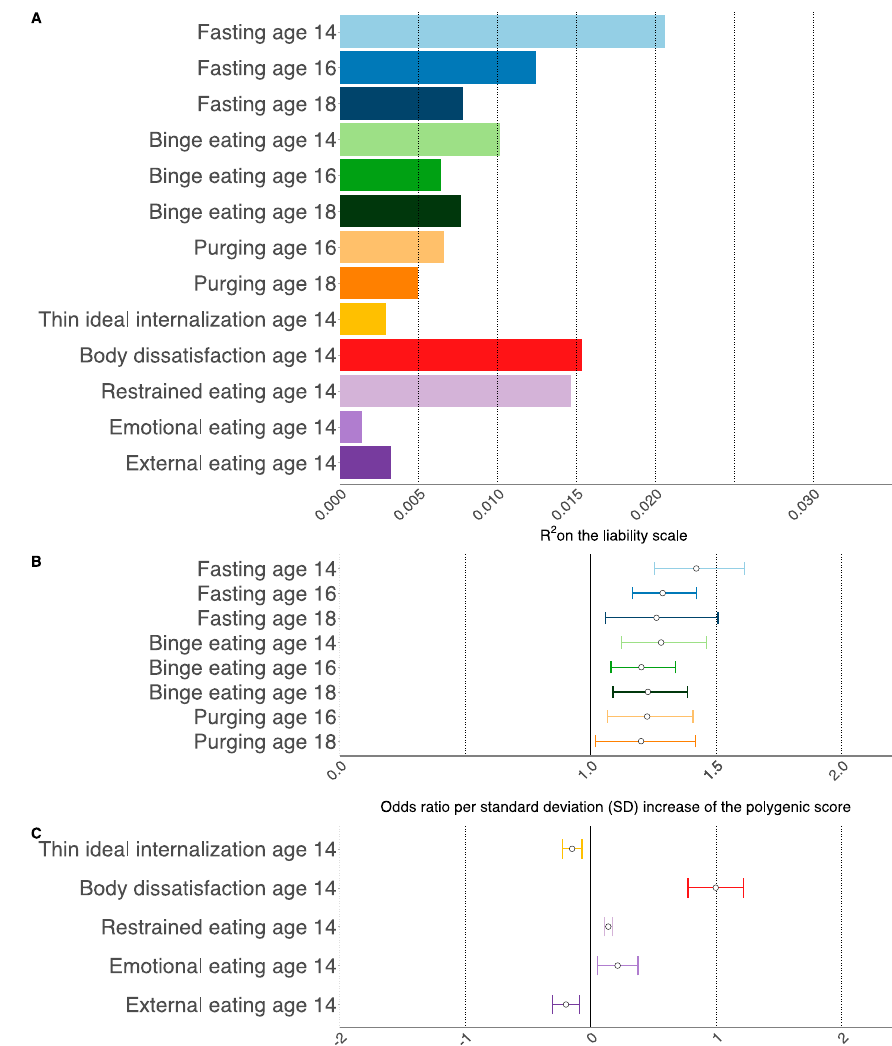
Figure 1. Association between the body mass index polygenic score (BMI-PGS) and disordered eating (DE) behaviors and cognitions in the Avon Longitudinal Study of Parents and Children using generalized linear models [30–33]. Analyses were corrected for biological sex. Age is measured in years. Sample sizes per outcome were fasting (age 14, n cases = 300, n controls = 4284; age 16, n cases = 516, n controls = 3328; age 18, n cases =143, n controls = 2443;), binge eating (age 14, n cases = 257, n controls = 3887; age 16, n cases = 434, n controls = 2902; age 18, n cases =365, n controls = 1545;), and purging (age 16, n cases = 237, n controls = 3634; age 18, n cases= 166, n controls = 2416), thin ideal internalization ( n = 4496), body dissatisfaction ( n = 4625), restrained eating ( n = 4530), emotional eating ( n = 4345), external eating ( n = 3995). ( A ) Explained variance as measured by Nagelkerke’s Pseudo squared multiple correlation (R 2 ) for the DE phenotypes. All associations were statistically significant (False Discovery Rate-corrected Q-values < 0.05) except for purging at age 18 years. ( B ) Effect size of the association between the standardized BMI-PGS (to mean zero and standard deviation of one) as measured by odds ratios (ORs) and the DE behaviors. The dots represent the point estimates of the ORs for an increase of one standard deviation in the BMI-PGS and the lines represent the 95% confidence interval of the point estimate. ( C ) Effect size of the association between the standardized BMI-PGS (to mean zero and standard deviation of one) as measured by standardized betas and the DE cognitions. The dots represent the point estimates of the standardized betas for an increase of one standard deviation in the BM-PGS and the lines represent the 95% confidence interval of the point estimate.